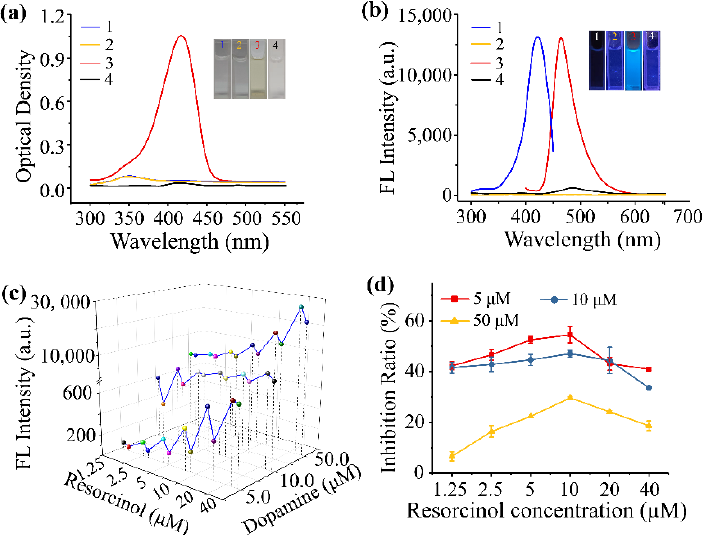
Figure 1. The ( a ) UV-vis absorption spectra and ( b ) fluorescence spectra of four solutions (named by 1, 2, 3 and 4), ( c ) fluorescence intensity and ( d ) inhibition ratio for dopamine and resorcinol con- centration-response. Four numbers (1 – 4) inserted in the figures means dopamine, resorcinol, the mixture solution of dopamine and resorcinol, the mixture solution of dopamine, resorcinol and rongalite, respectively.